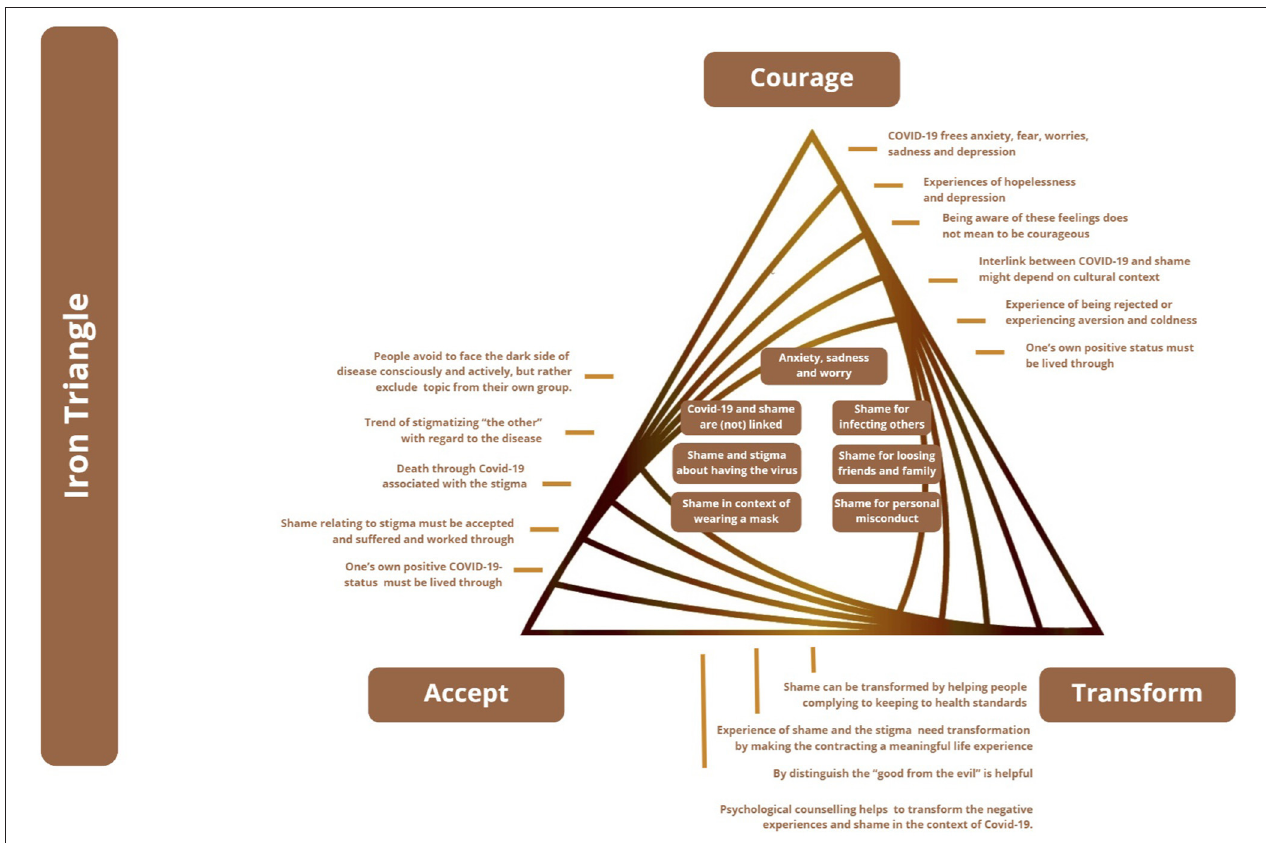
FIGURE 2 | The Iron Triangle, based on Wong